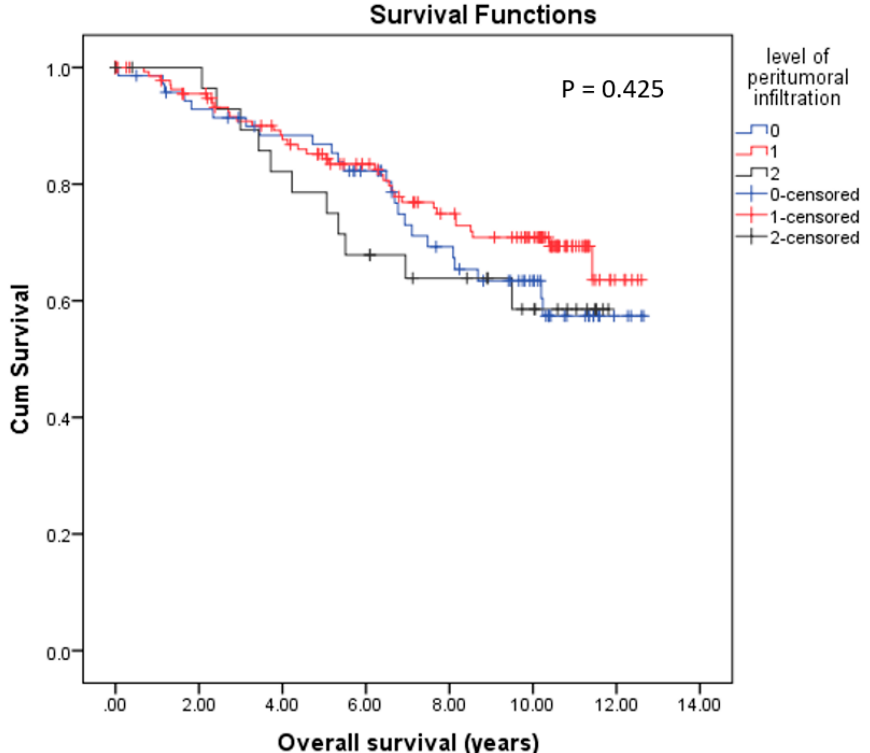
Figure 7. Kaplan–Meier survival analyses of the level of peritumoral inflammation in relation to overall survival (OS) showed no significant differences ( p = 0.425).